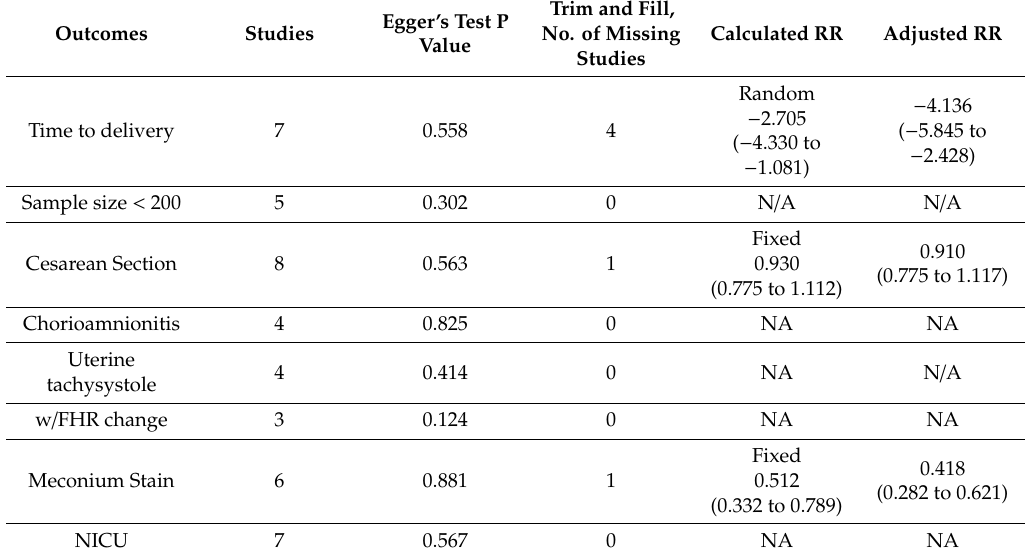
Table 3. Publication